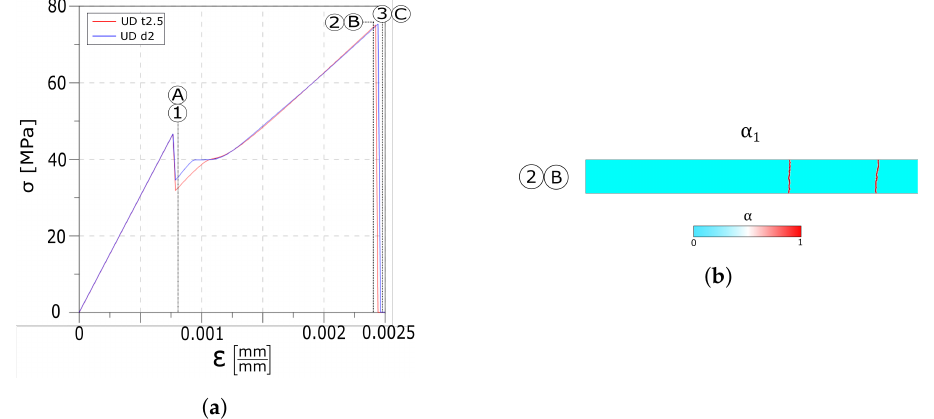
Figure 10. Numerical results. ( a ) Global stress–strain response. ( b ) UD t2.5 and UD d2 crack overview in the first